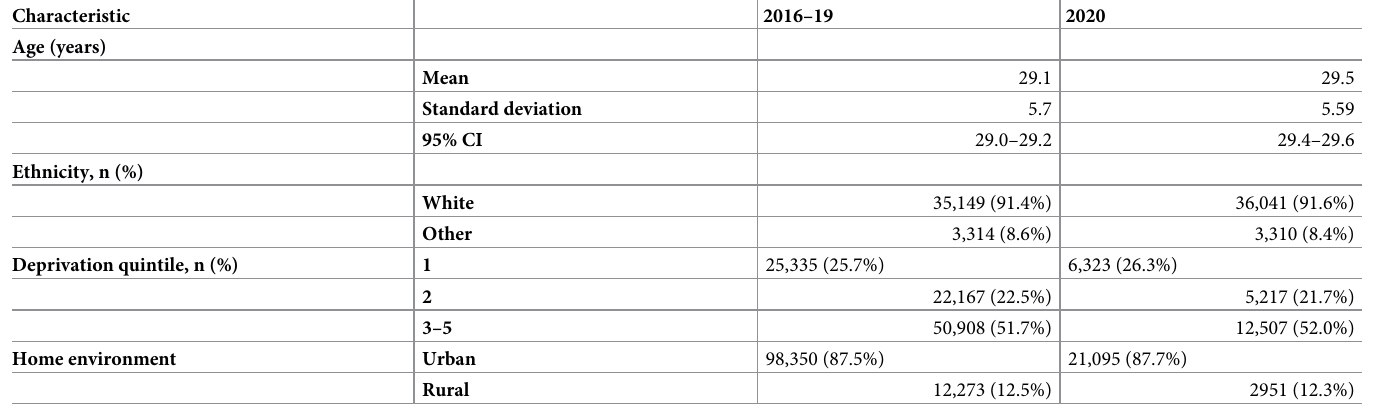
Table 3. Demographic details of mothers of babies in the SAIL